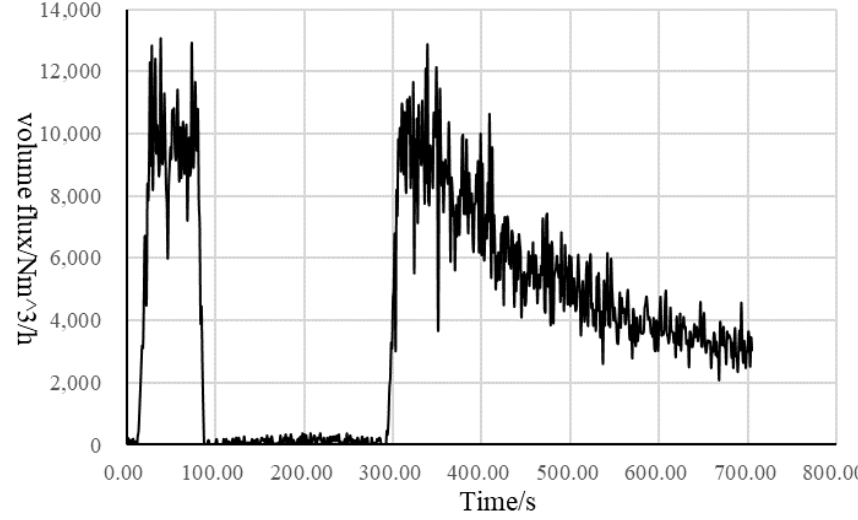
Figure 9. The exhaust volume flux variation of the FSDS. Table 6. List of the calculated FSDS operating performance parameters.